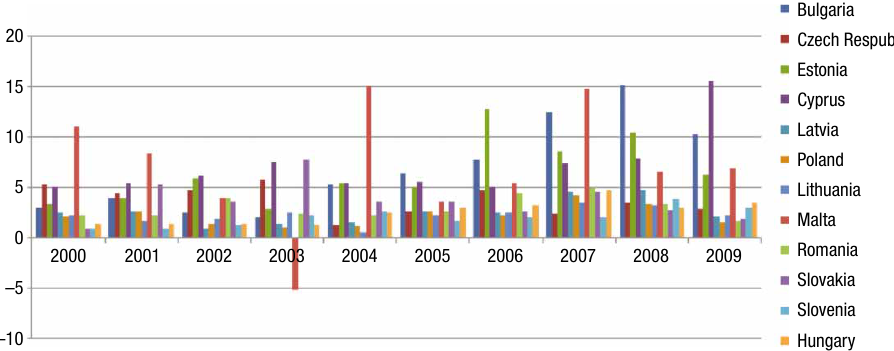
Fig. 2. The variation of FDI intensity over 2000–2009, Central and Eastern